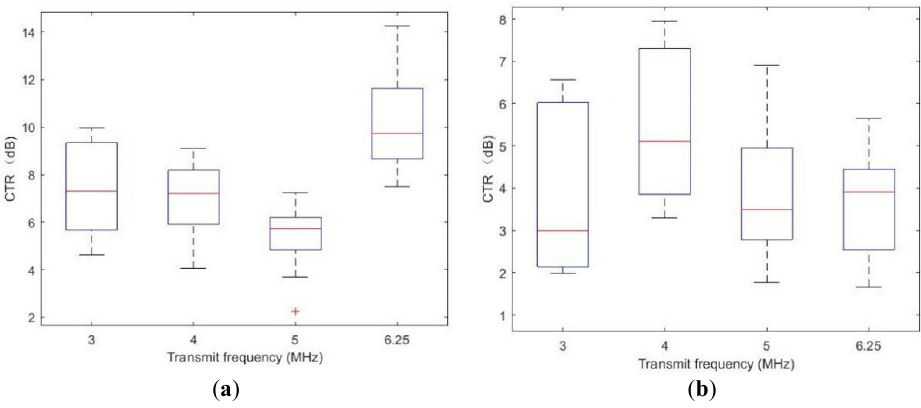
Figure 10. Increase in CTR with bubble region detection: ( a ) Increase in CTR between region detection and ESBMV; and ( b ) increase in CTR between region detection and BWT.